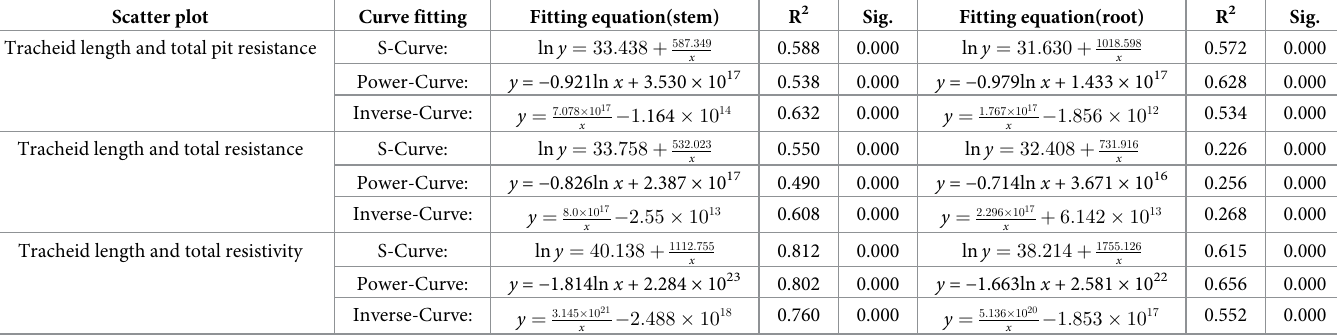
Table 6. Correlation coefficient of total pit resistance, total resistance and total resistivity. Scatter plot